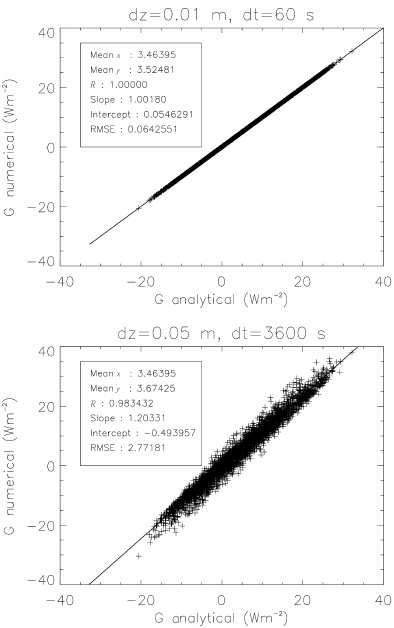
Figure 5. Comparison of the resulting ground heat fluxes from the fine and coarse spatial and temporal resolutions to the analytical